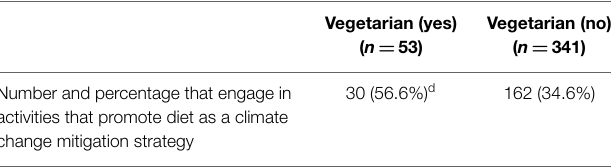
TABLE 2 | Logistic regression analyses predicting strong agreement or agreement that climate change is an important issue based on demo- graphic variables .